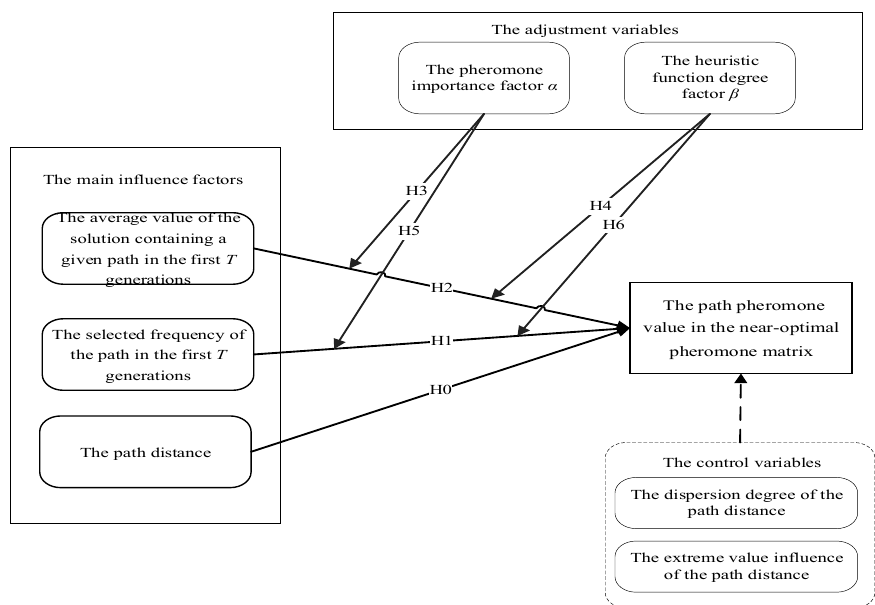
Figure 2. The conceptual diagram of the hypothesis